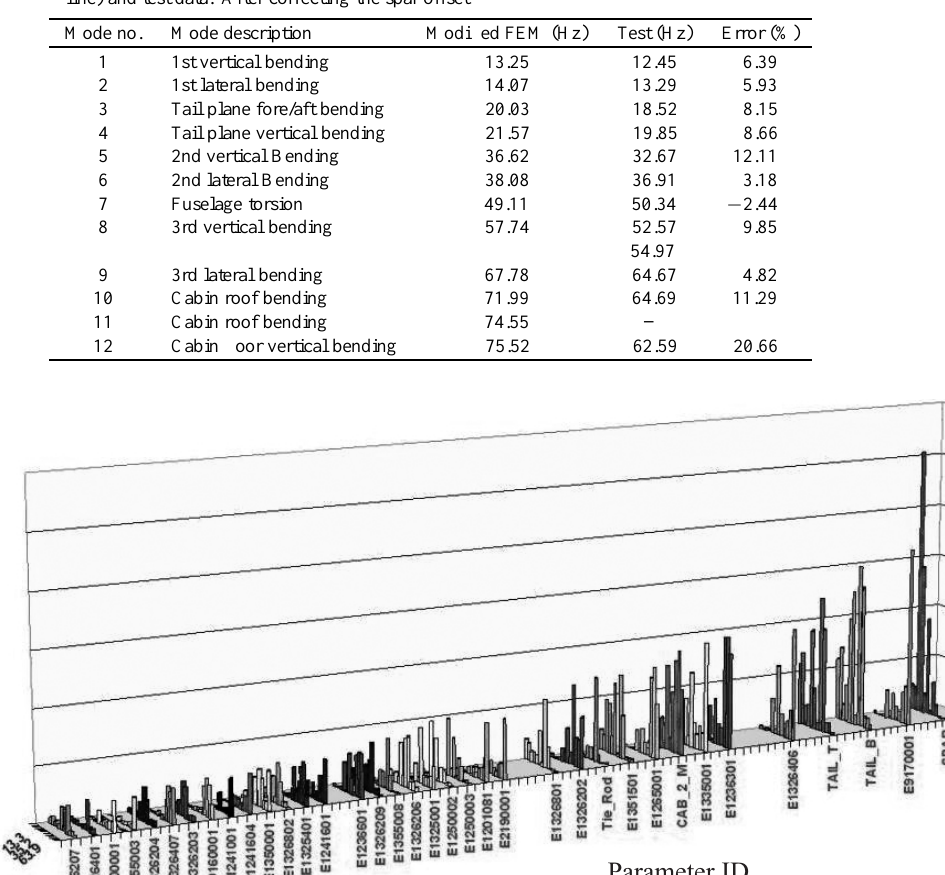
Table 3 Predicted natural frequencies (Hz) and errors (%) between the finite element model (base